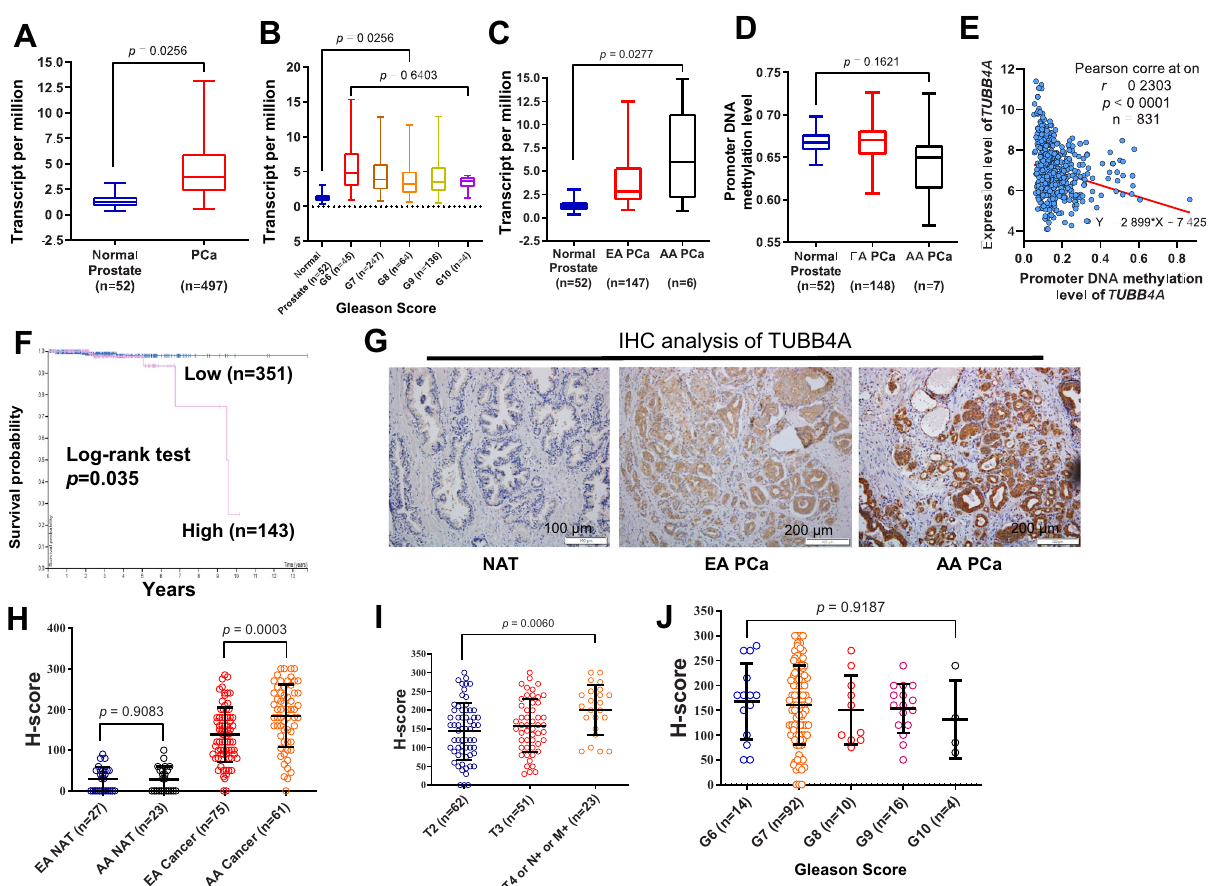
Fig. 1 TUBB4A expression in normal prostate and prostate cancer tissues. Differential expression of TUBB4A A between normal prostate and prostate cancer tissues, B between tumor tissues with different Gleason scores, and C between AA and EA tumor tissues from TCGA dataset. Numbers in parentheses indicate the sample size. D DNA methylation of TUBB4A promoter (TCGA dataset). E Correlation of mRNA expression levels with DNA methylation levels in the CpG island of TUBB4A in prostate cancer samples (TCGA dataset). F Kaplan – Meier survival curves for TUBB4A expression with low and high levels in TCGA prostate cancer patients. G Representative IHC staining in normal prostate and prostate cancer tissues with anti-human TUBB4A mAb (Abcam, ab11315) from UAB prostate cancer specimens. Scale bars, 100 μ m or 200 μ m. This experiment was repeated two times. H – J Quantitative H-scores for prostate cancer samples from European and African American ancestry and tumor stages and Gleason scores. Data are presented as the medians and interquartile ranges as determined with a Kruskal – Wallis ( B – D ) or Mann – Whitney U ( A – D ) test. Data are presented as the means and standard deviation (SD) as determined with an ANOVA followed by Tukey ’ s post hoc t test ( H – J ). Source data are provided as a Source data fi le. AA: African-American; EA: European-American; NAT: Normal prostate tissue adjacent to the